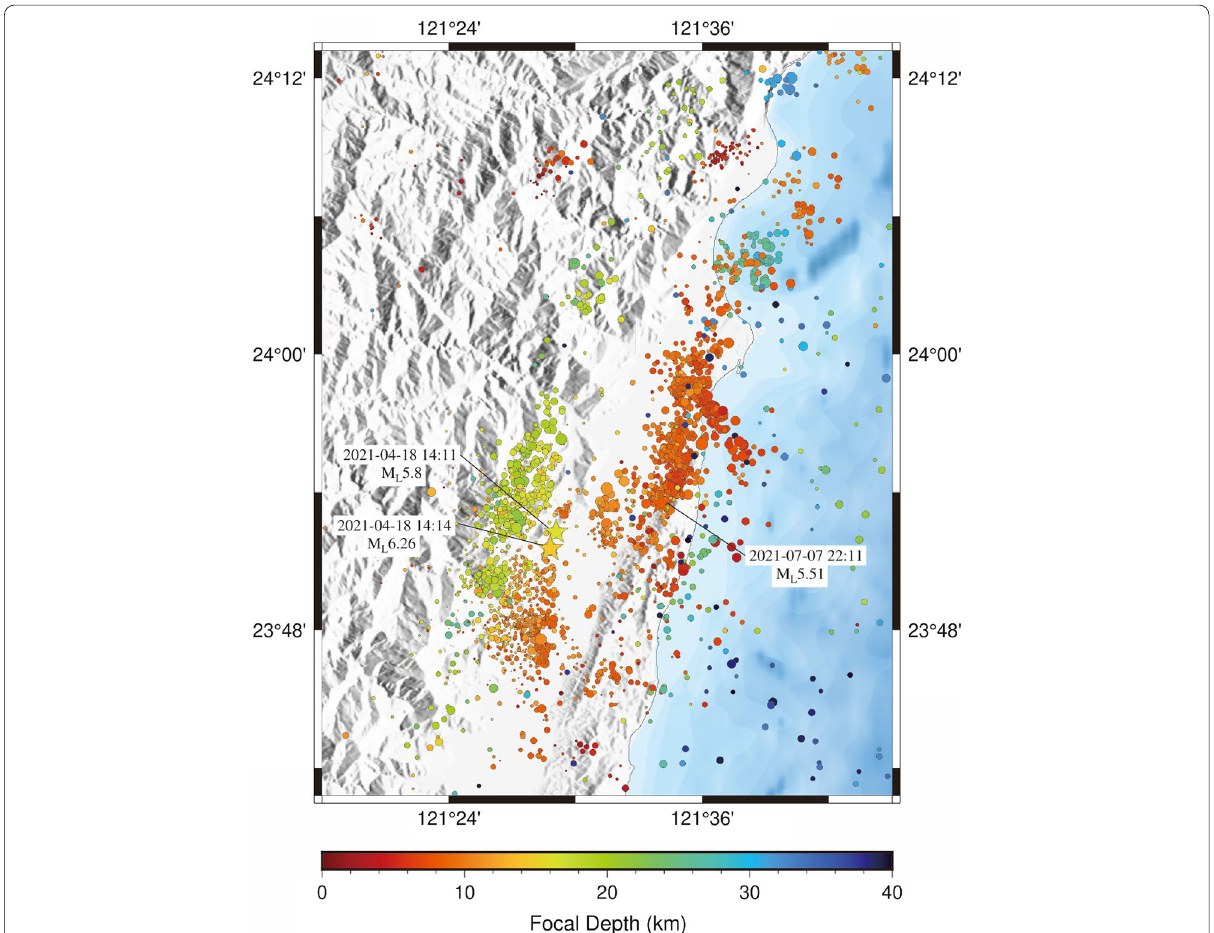
Fig. 1 The crustal ( 40 km) Hualien earthquake swarm activities observed from April to December of 2021. Star symbols show the epicenters of ≤ the largest three earthquakes in this time period. Rainbow color represents the focal depth of each event. The radius of each circle is proportional to the observed M L